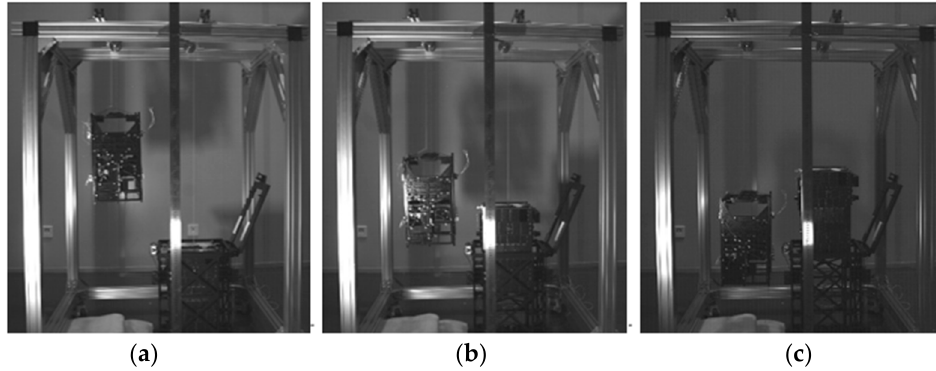
Figure 19. Separation process. ( a ) Initial state; ( b ) Intermediate state; ( c ) Popup state.